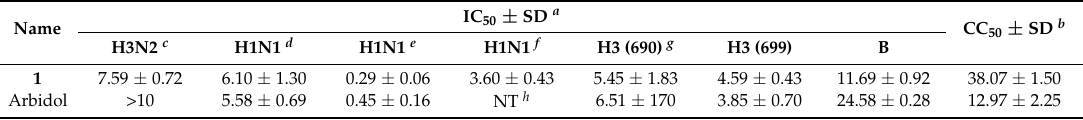
Table 1. The anti-influenza viral activity and cytotoxicity of 1 (µg/mL).